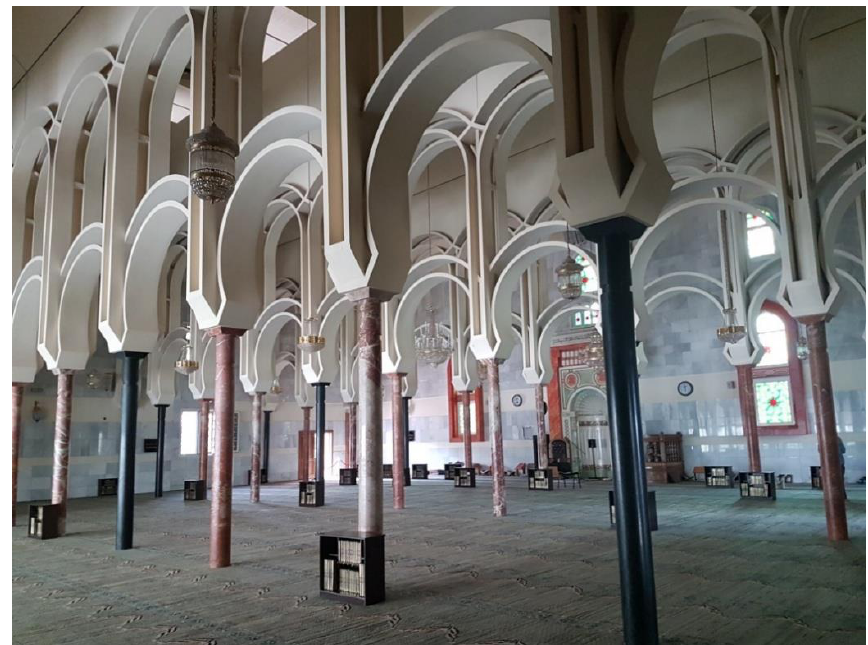
Figure 9. Prayer hall of the Omar Mosque and the Islamic Cultural Centre (1977). Photo took by author.